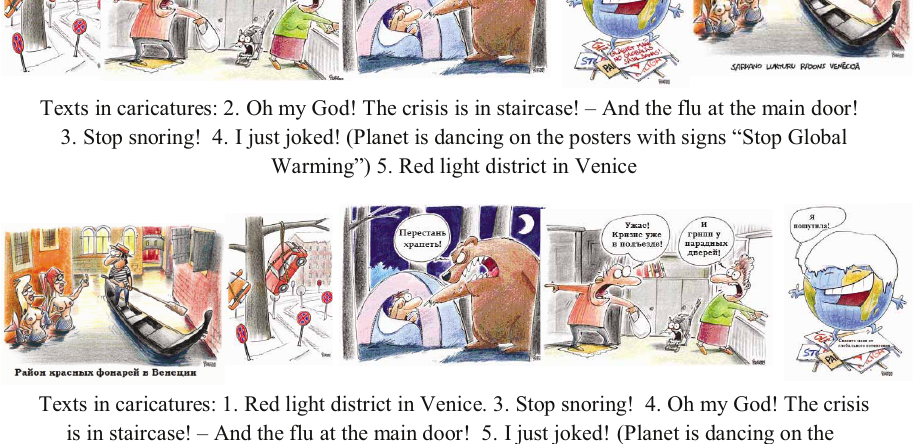
Figs. 4–5. Author: Gatis Š ļū